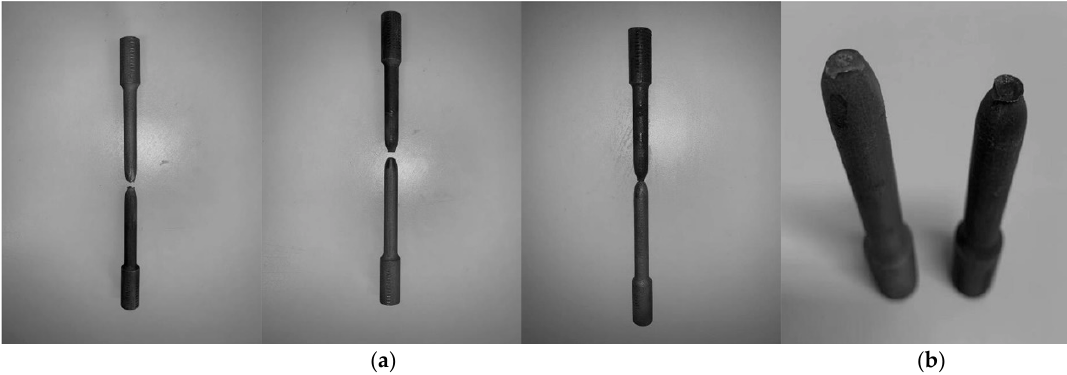
Figure 7. ( a ) Three sets of standard tensile test pieces after breaking; ( b ) Necking phenomenon of tensile test piece.